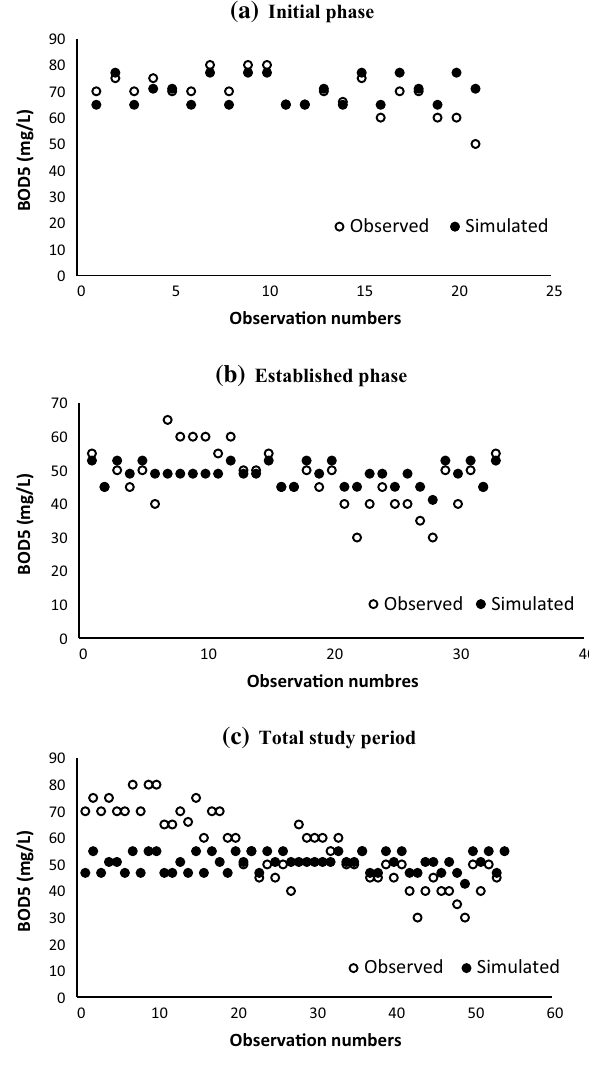
Fig. 6 Comparison of observed and simulated BOD for K-S*